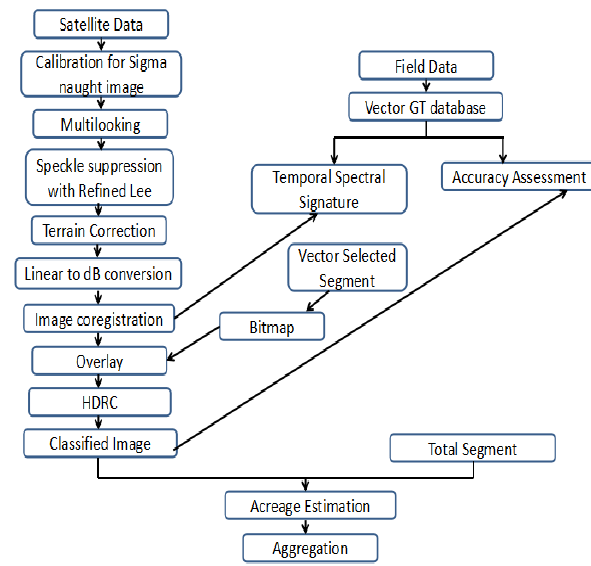
Figure 6: Flow diagram for SAR data